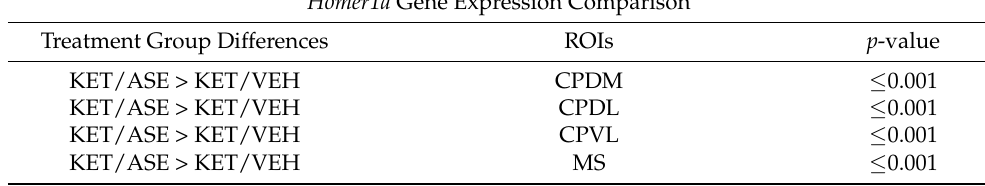
Table 6. Summary of the significant findings. Asterisks represent couples of correlations in which significant differences are